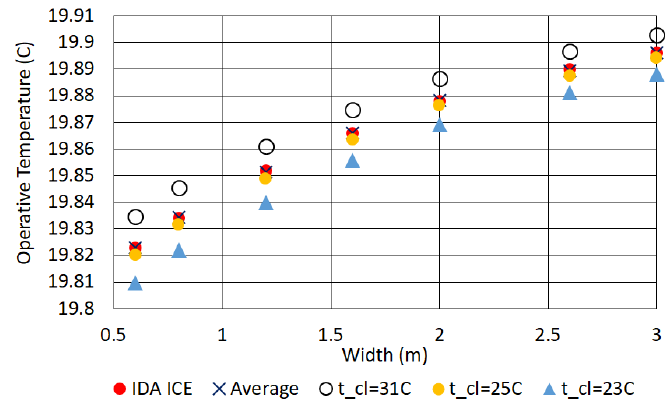
Figure A1. Operative temperatures for a 21-type, IDA ICE cross-check: arithmetic (crosses) vs. weighted average for different clothing surface temperatures.